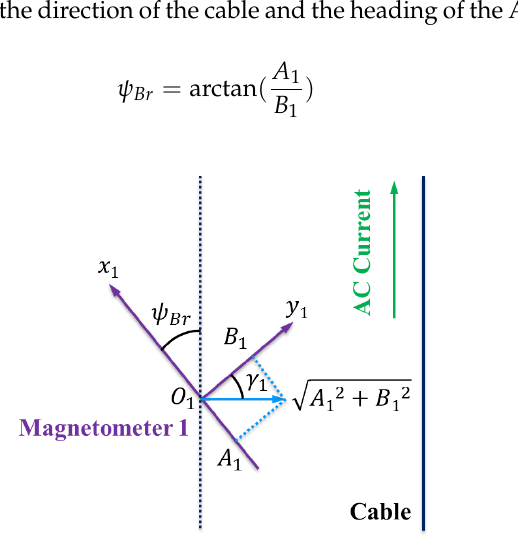
Figure 3. For the tri-axial Magnetometer 1, the induced electromotive force projected in the horizontal plane is perpendicular to the cable. Obviously, tan γ 1 = A 1